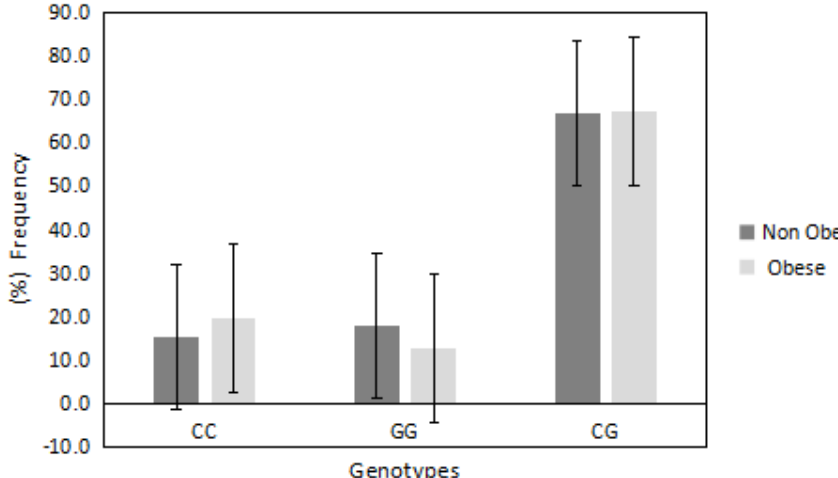
Figure 2. The frequency of PDE4D/rs295978 genotypes in obese and non-obese groups. The heterozygote mutated CG genotype was semi-equal in the obese and non-obese groups. The wild-type CC genotype was relatively higher in the obese group compared with the non-obese group, while the mutated GG genotype was lower in the obese group compared with the non-obese group.